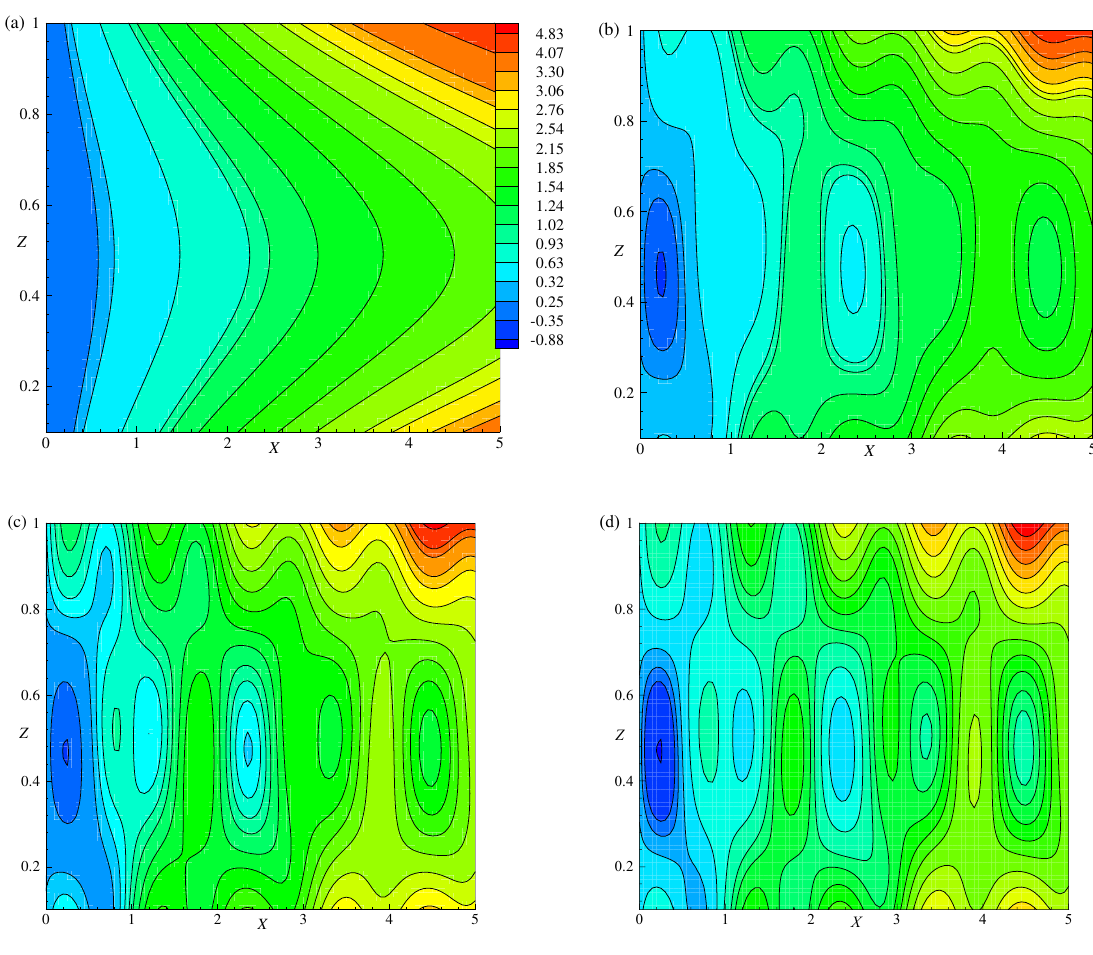
Figure 14. Heatlines for R (cid:39) R co ( a ), R = 3 R co ( b ), 5 R co ( c ), and 7 R co ( d ) for Le = 0.04, ψ = − 0.03, χ = 0.2 and t = 0.8.